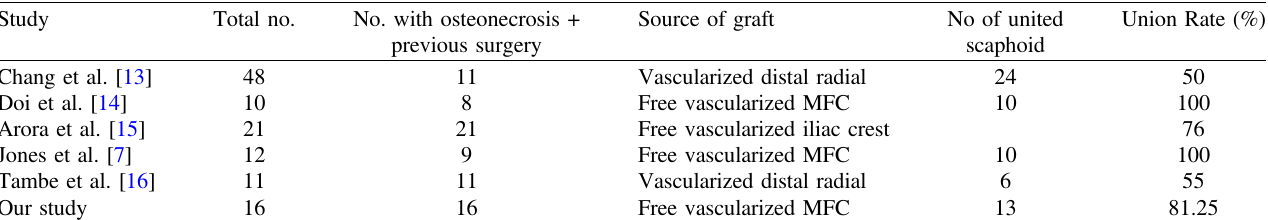
Table 2. Outcomes of revision surgery for scaphoid nonunion with proximal pole osteonecrosis nonunion treated with MFC-free vascularized graft vascularized bone